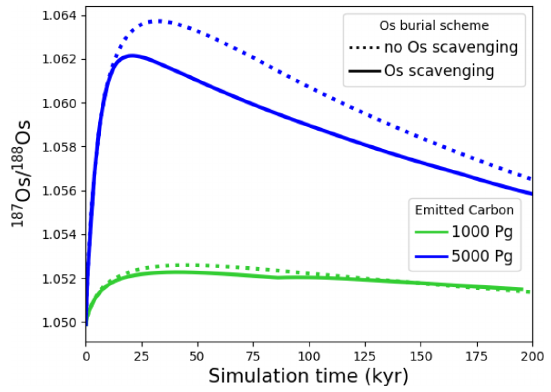
Figure B1. Time series of marine δ 7 Li changes in response to an immediate release of two different amounts of C into the atmosphere–ocean system with and without effects of the ratio of weathering to denudation rate ( W/D ) and temperature on the com- position of riverine Li.